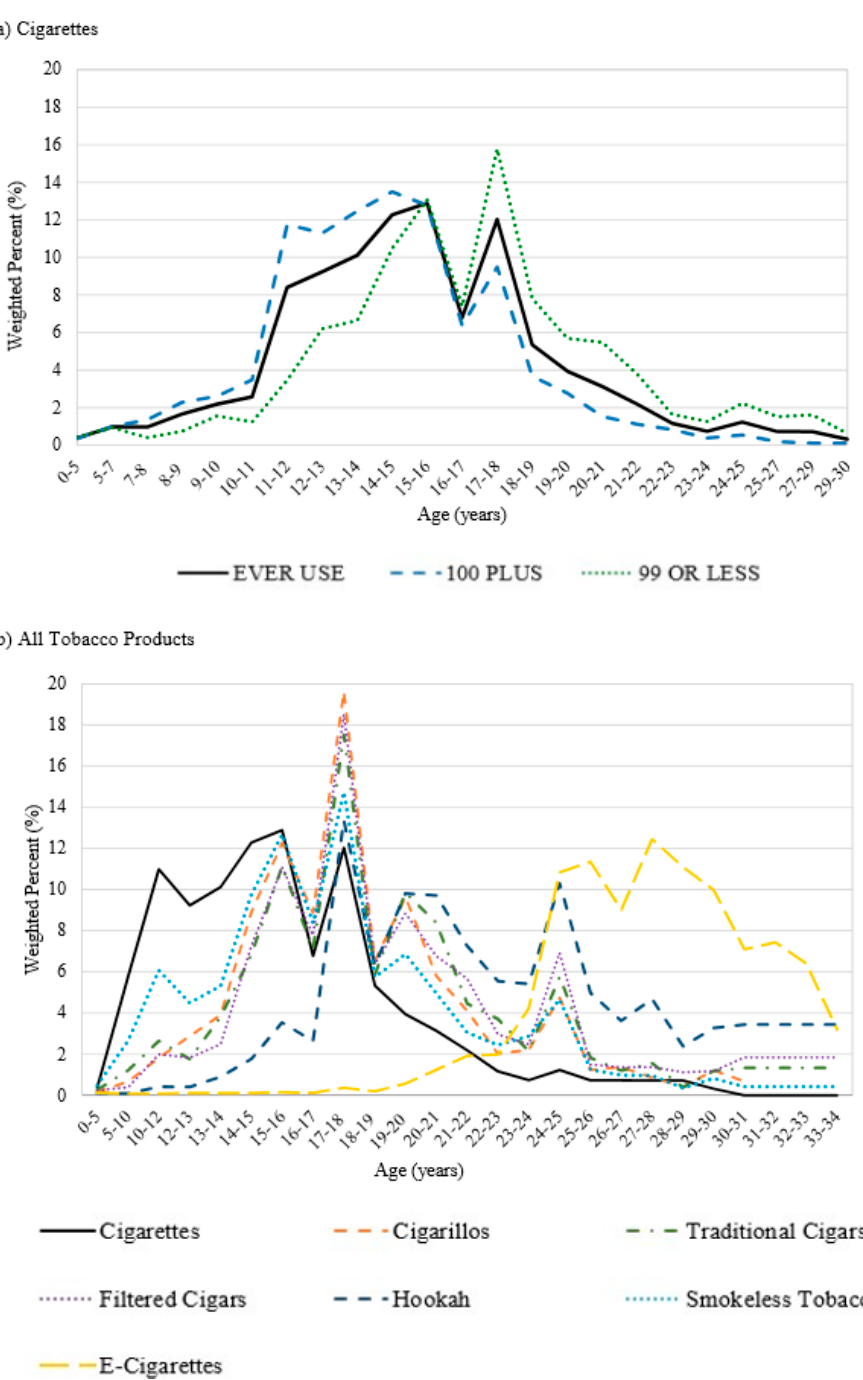
Figure 2. Histograms of the recalled age of initiation of TP use among PATH wave 1 26–34 year olds.